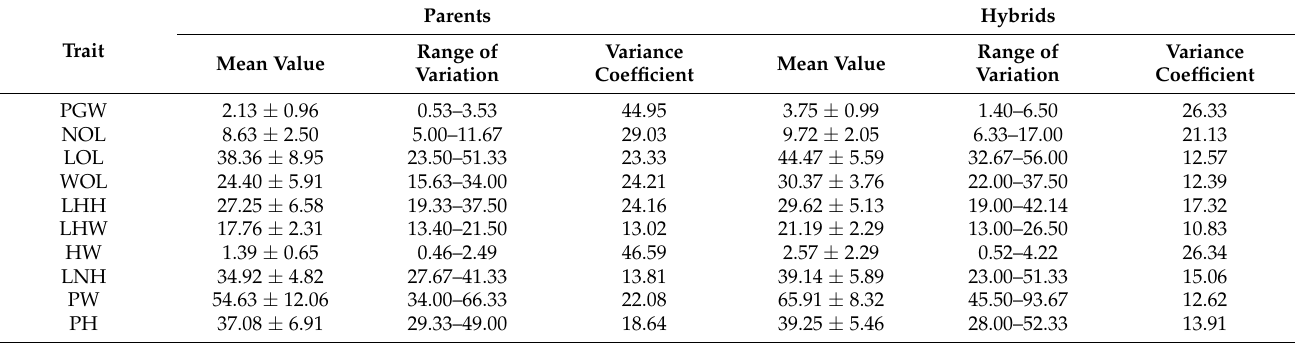
Table 2. Analysis of phenotype variation of traits for parental inbred lines and hybrids.